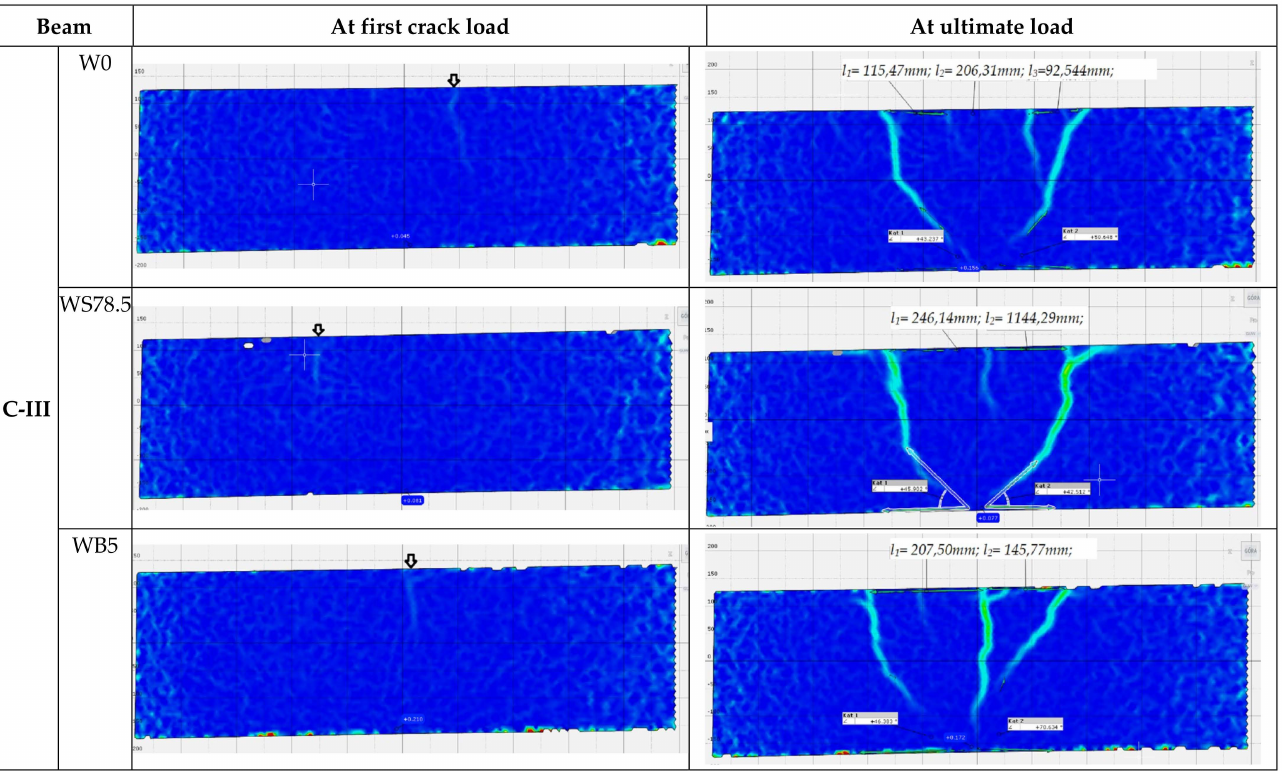
Figure 10. Principal strain contours in the center support in C-III series ( l is spacing between cracks in